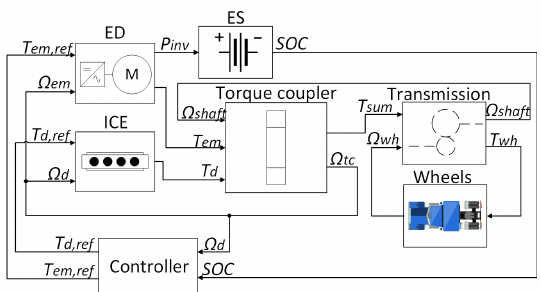
Figure 1: Layout example of parallel hybrid model